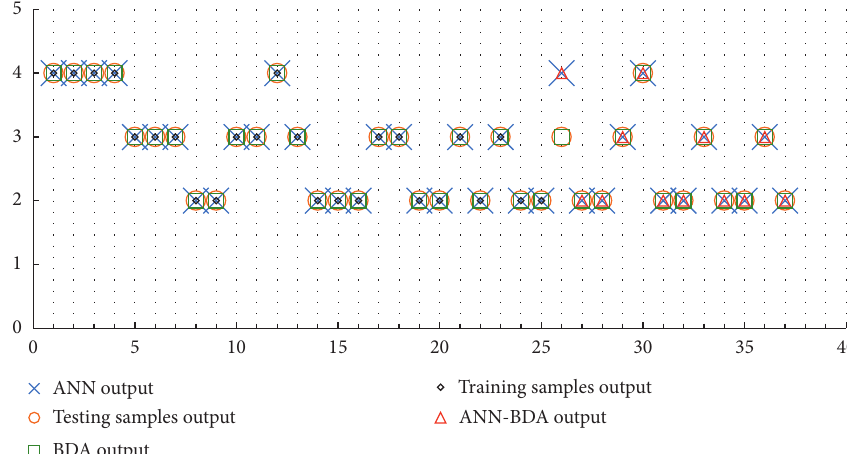
Figure 5: Training effects and the prediction results for situation 2.